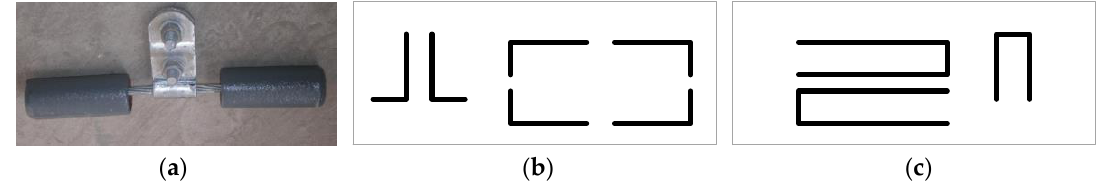
Figure 8. Feature samples of damper: ( a ) Photo of damper; ( b ) 2AS local contour; ( c ) 3AS local contour.